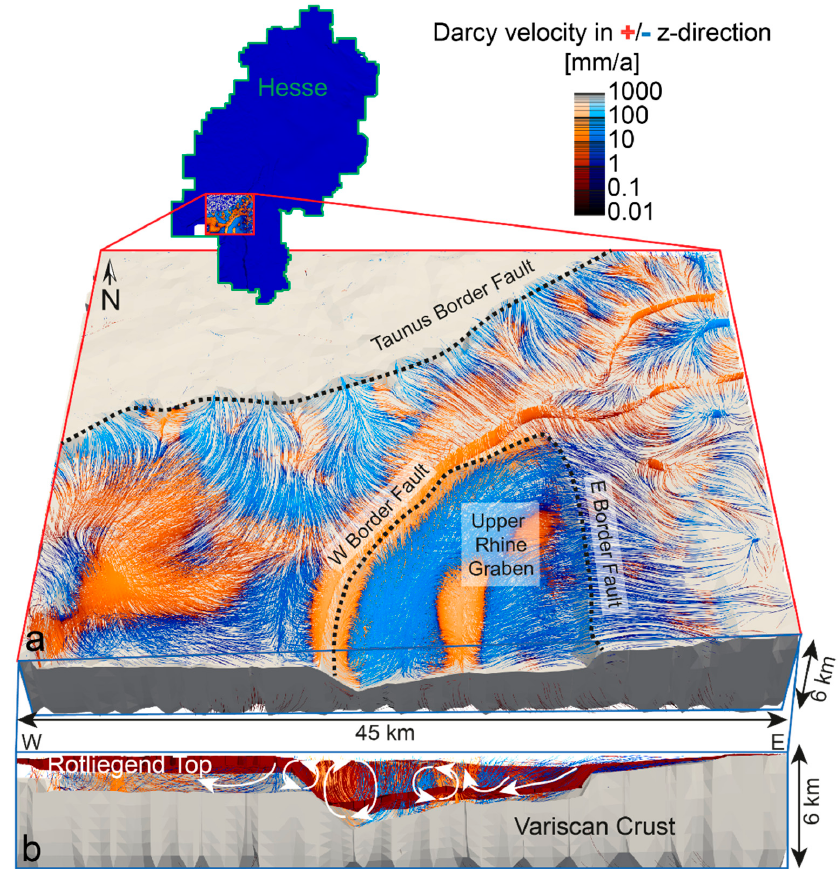
Figure 11. 3D visualization of simulated streamlines in a transient state after 100,000 years of simulation time. The color code shows in red Darcy velocities in the positive z-direction (upflow) and in blue in the negative z-direction (downflow). With velocities from black over dark colors to light colors into white. ( a ) Streamlines above the Variscan crust in a block in South-West Hesse, ( b ) profile perpendicular to the Upper Rhine Graben with streamlines in Cenozoic and Rotliegend sediments. White arrows highlight the simulated fluid circulation in the Upper Rhine Graben.